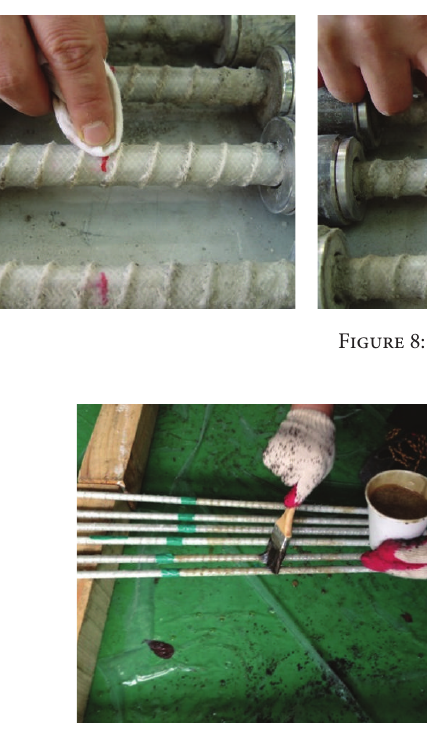
Figure 9: Coating with iron shavings.